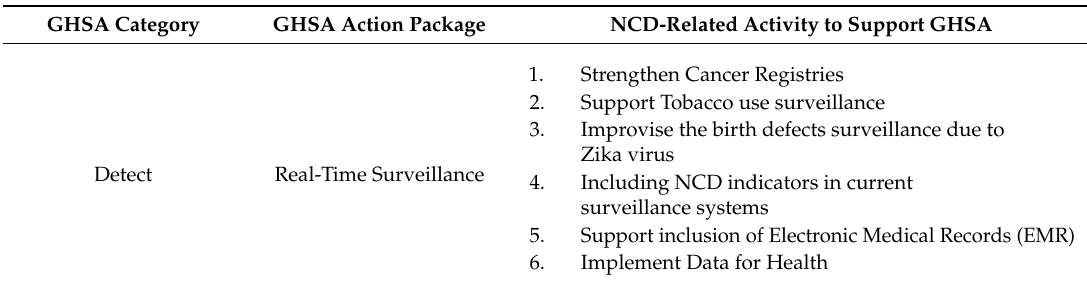
Table2. Real-time surveillance for non- communicable diseases within theglobal healthsecurity Table 2. Real-time surveillance for non- communicable diseases within the global health security agenda.